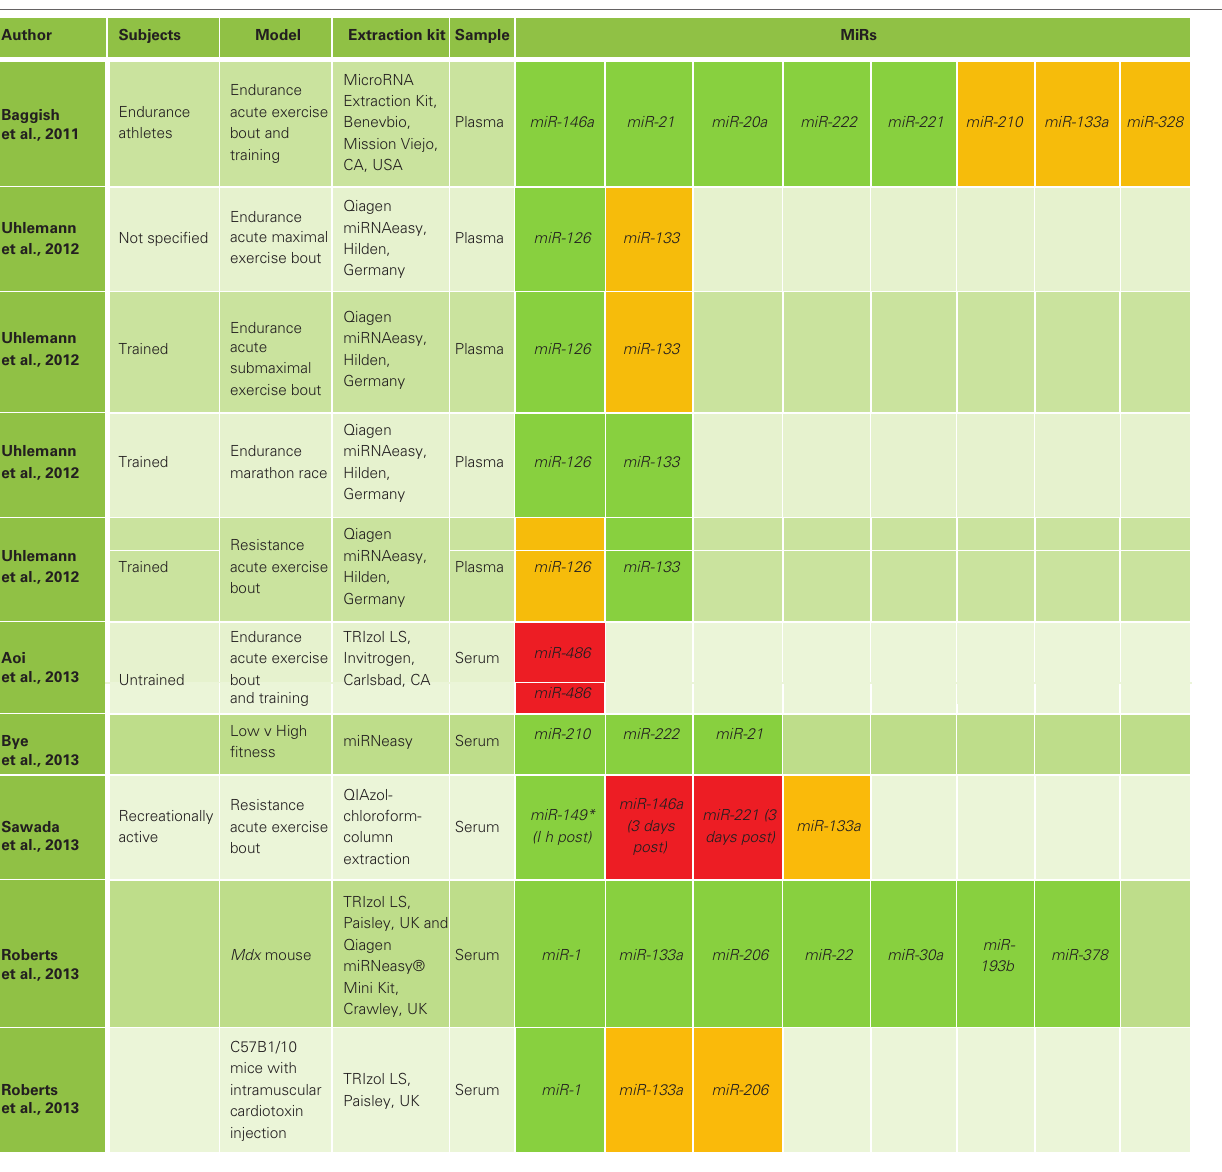
Table 2 | Regulation of circulating miRNAs by exercise, training, and fitness